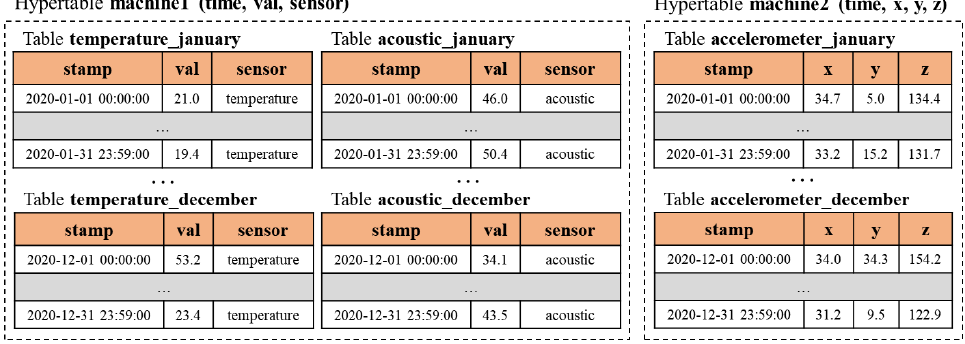
Figure 9. Hypertables in TimescaleDB.